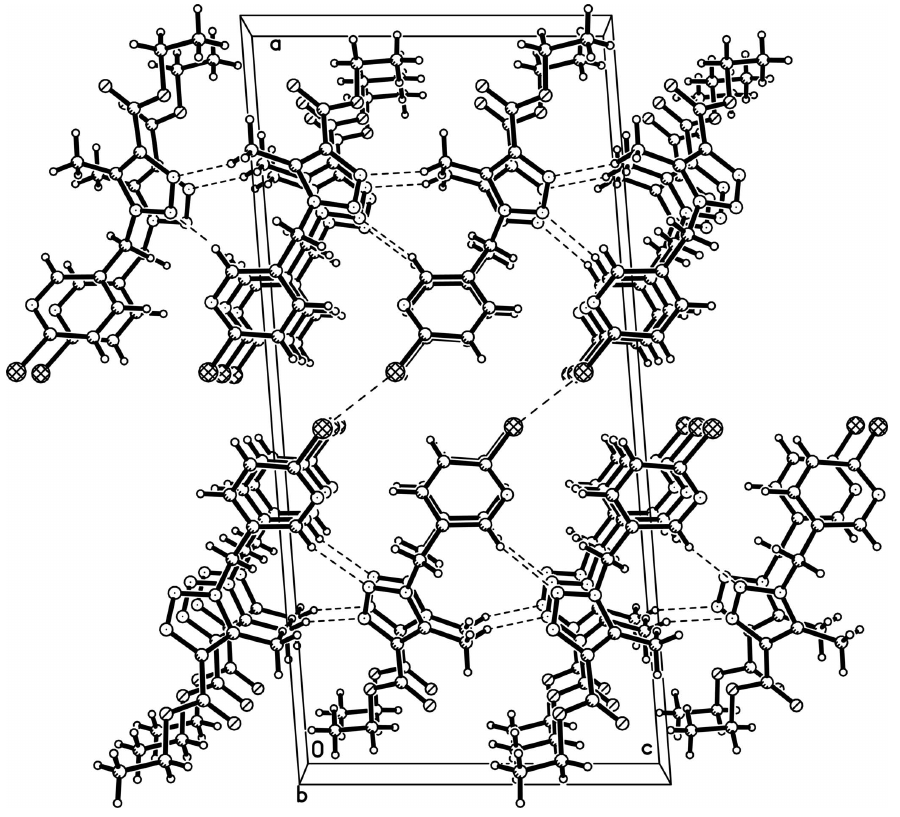
Figure 2 A partial view of the crystal packing of (I), showing the formation of C—H···O and C—H···N hydrogen-bonds (dashed